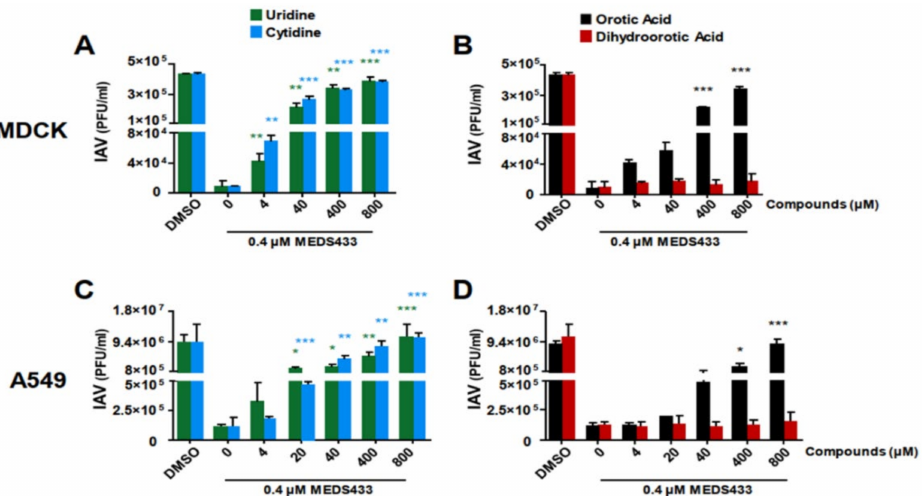
Figure 5. Uridine and orotic acid reversed the inhibitory effect of MEDS433 on IAV replication. ( A , B ) PRAs were performed in IAV-infected MDCK cells treated before, during, and post-infection with 0.4 µ M MEDS433 in the presence of increasing concentrations of uridine or cytidine ( A ) and dihydroorotic acid or orotic acid ( B ). At 48 h p.i., the viral plaques were stained and microscopically counted. ( C , D ) VRAs were performed in A549 cells infected with IAV and treated with 0.4 µ M MEDS433 in the presence of increasing concentrations of uridine ( C ) and dihydroorotic acid or orotic acid ( D ). At 48 h p.i., the cell supernatants were harvested and titrated in MDCK cells. Data shown represent means ± SDs of three independent experiments performed in triplicate and analyzed by a one-way ANOVA, followed by Dunnett’s multiple comparison test. * ( p < 0.01); ** ( p < 0.001); *** ( p < 0.0001) compared to the calibrator sample (MEDS433